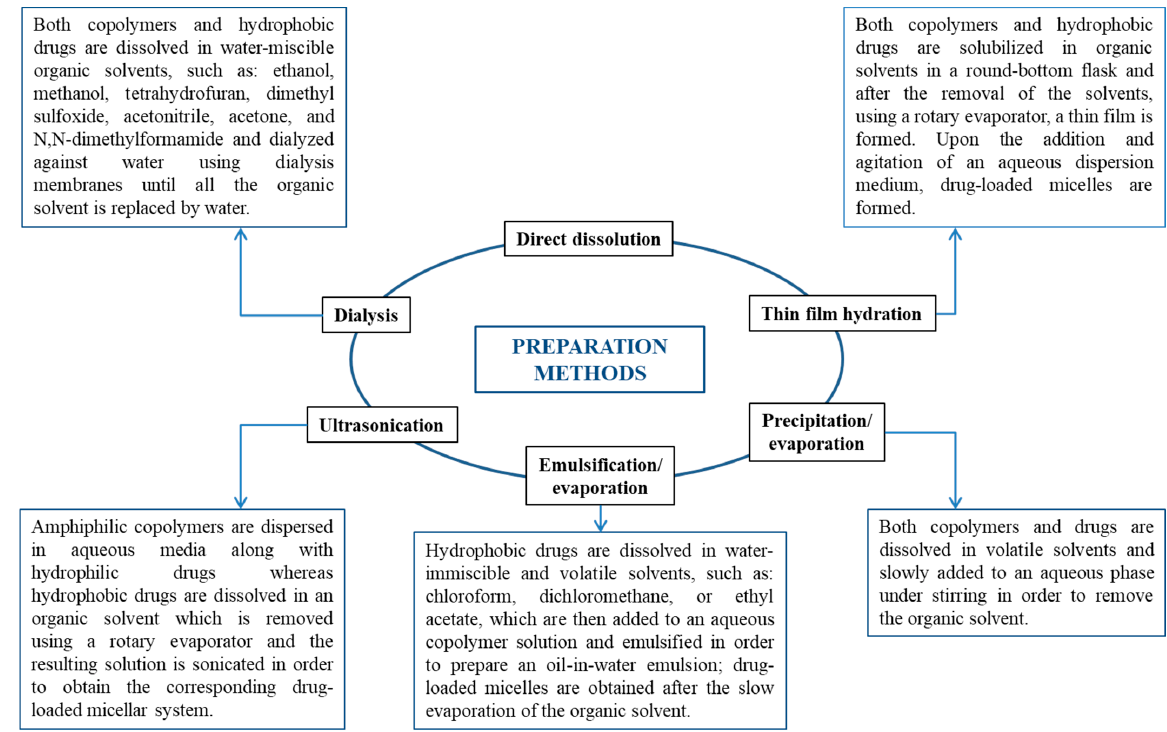
Polymers 2021 , 13 , x FOR PEER REVIEW Figure 3. Preparation methods of both empty and drug-loaded micellar systems. Figure 3. Preparation methods of both empty and drug-loaded micellar systems.